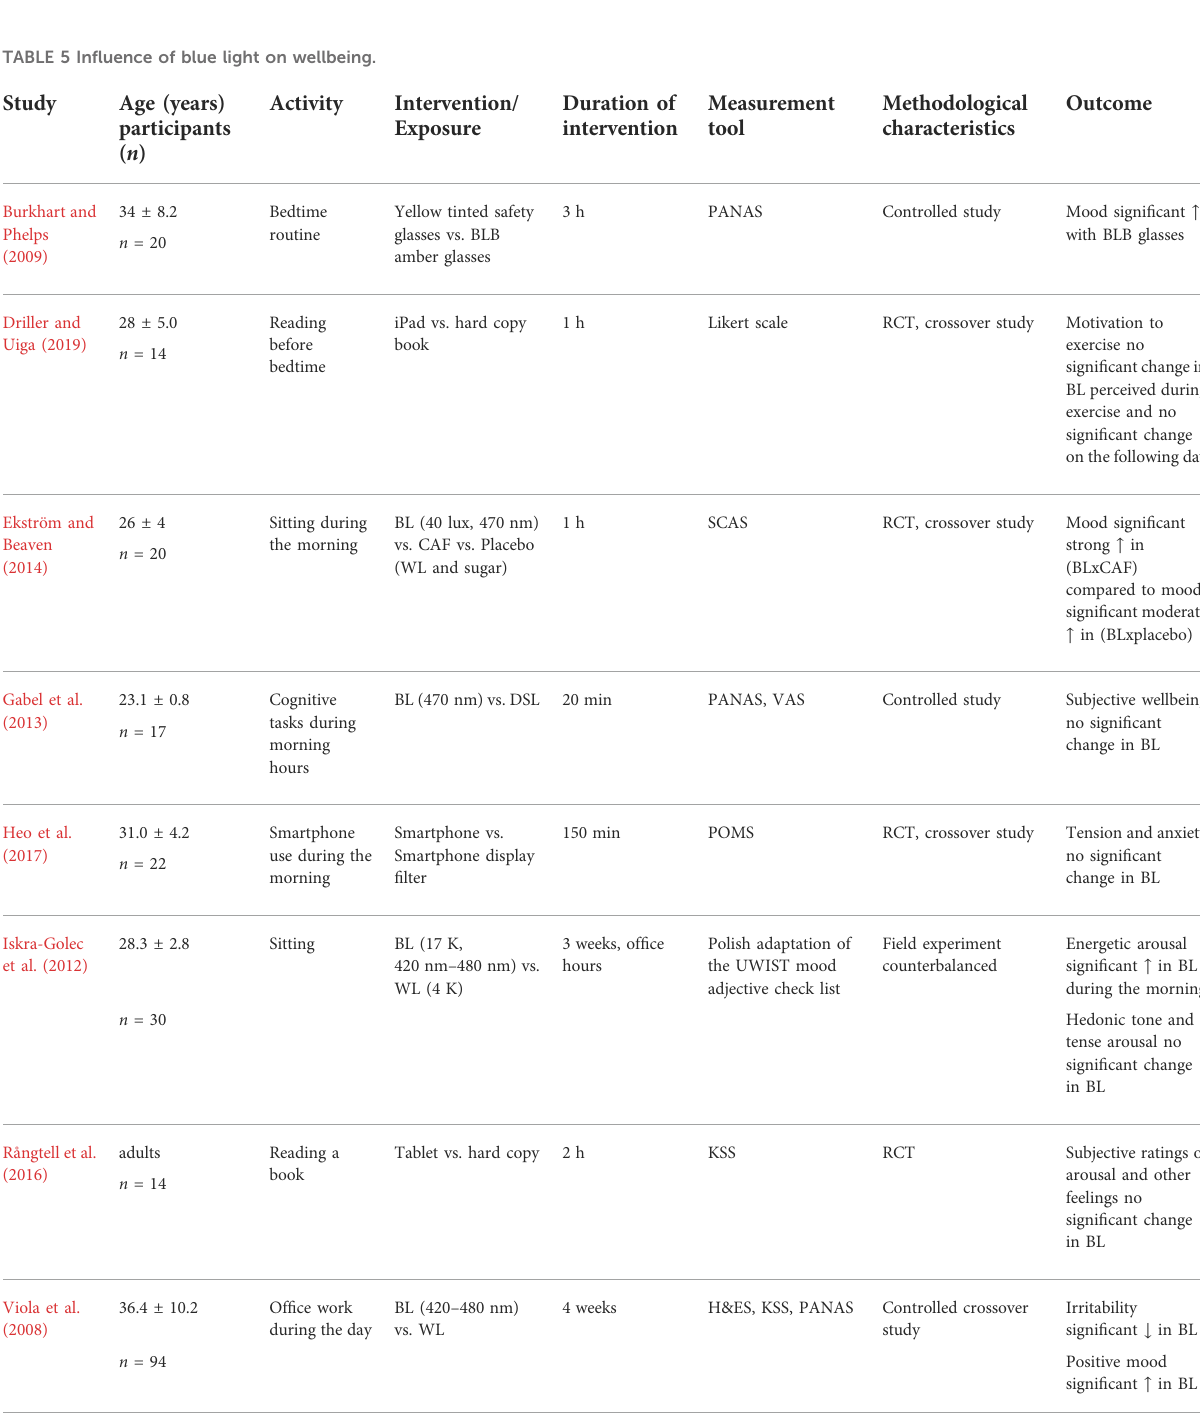
TABLE 5 In fl uence of blue light on